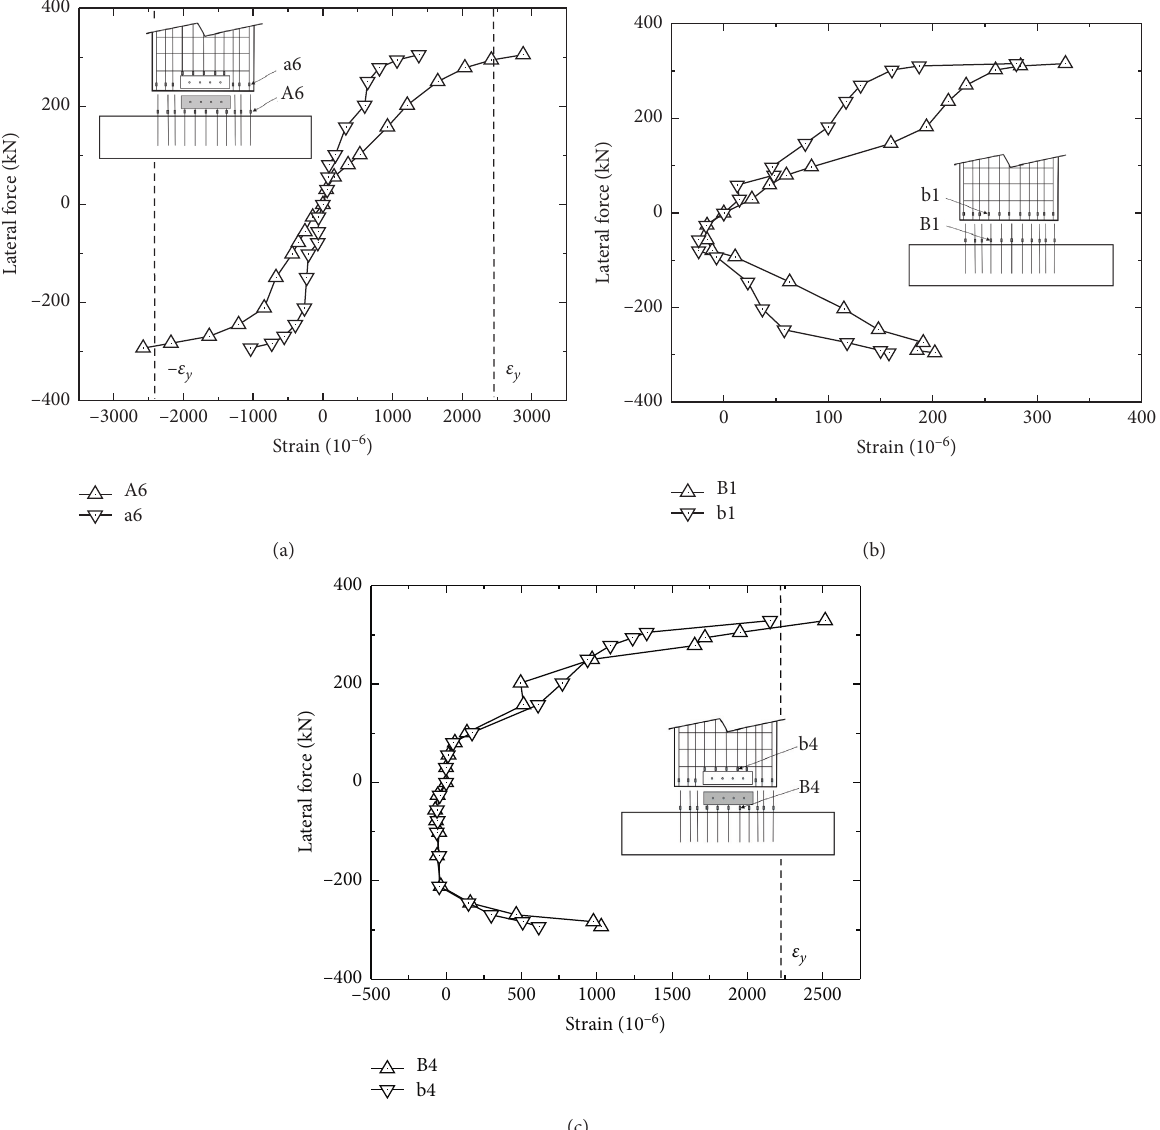
Figure 12: Skeleton curves of strain. (a) a6 and A6 of SRCSW2-2. (b) b1 and B1 of SRCSW2-1. (c) b4 and B4 of